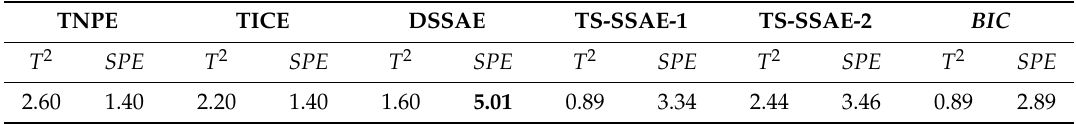
Table 3. Monitoring results of normal data in the Tennessee-Eastman process (FAR) / %.